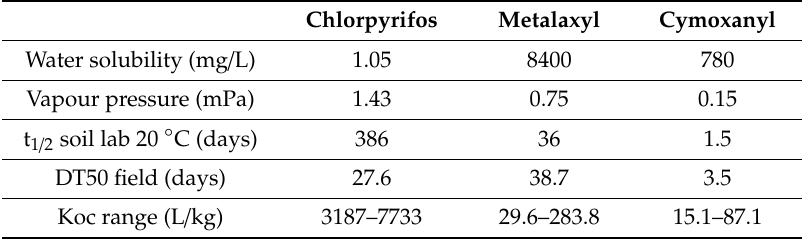
Table 2. Main physico-chemical characteristics of the pesticides used in the